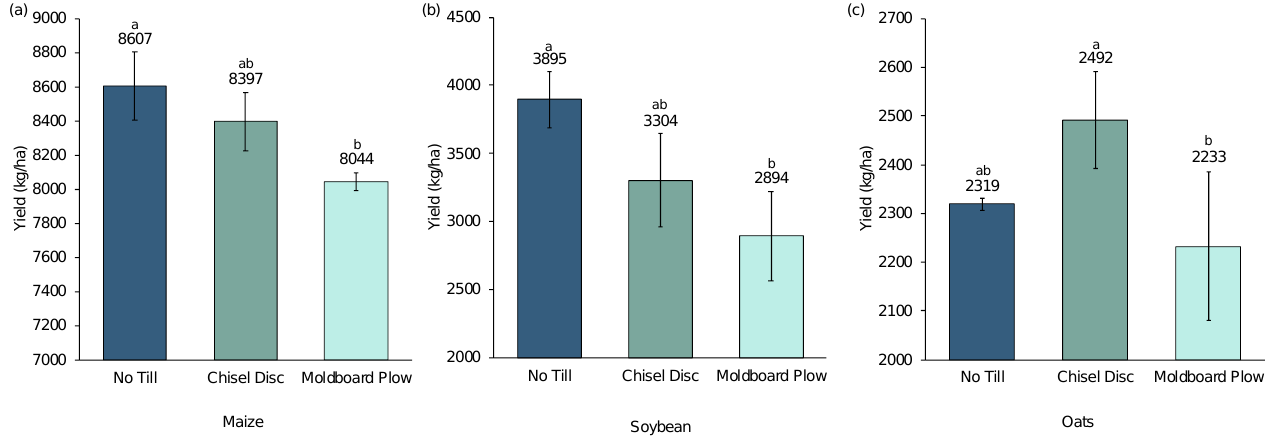
Figure 3. Ergothioneine production per hectare of crops ( a ) maize (2018), ( b ) soybean (2019), and ( c ) oats (2020) grown using different tillage methods; different letters above the bars indicate significant difference ( p > 0.05) within each crop type, error bars represent the standard deviation of each tillage type.